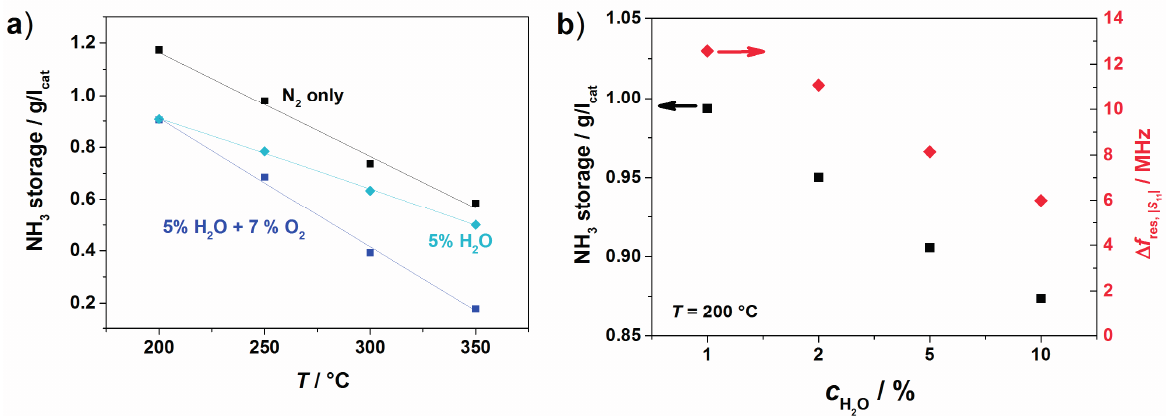
Figure 15. Cu-SSZ-13 honeycomb catalyst: ( a ) stored amount of NH 3 over temperature for different background gas compositions; ( b ) stored amount of NH 3 and resonance frequency shift for different H 2 O contents in background gas at 200